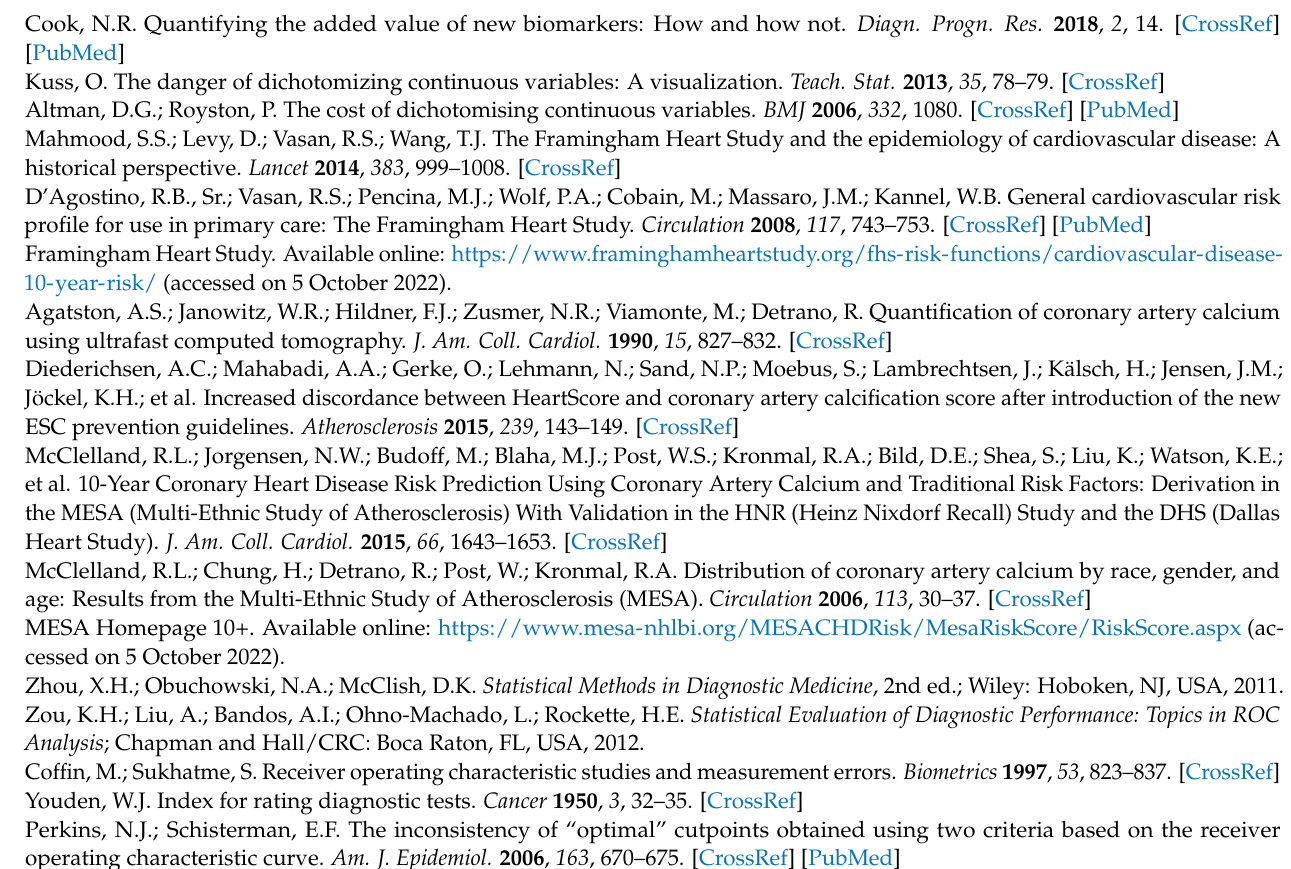
Figure A2. Histograms of the real-life example for previous cardiovascular disease ( upper panel ) and the ROC curve for this example ( lower panel ).